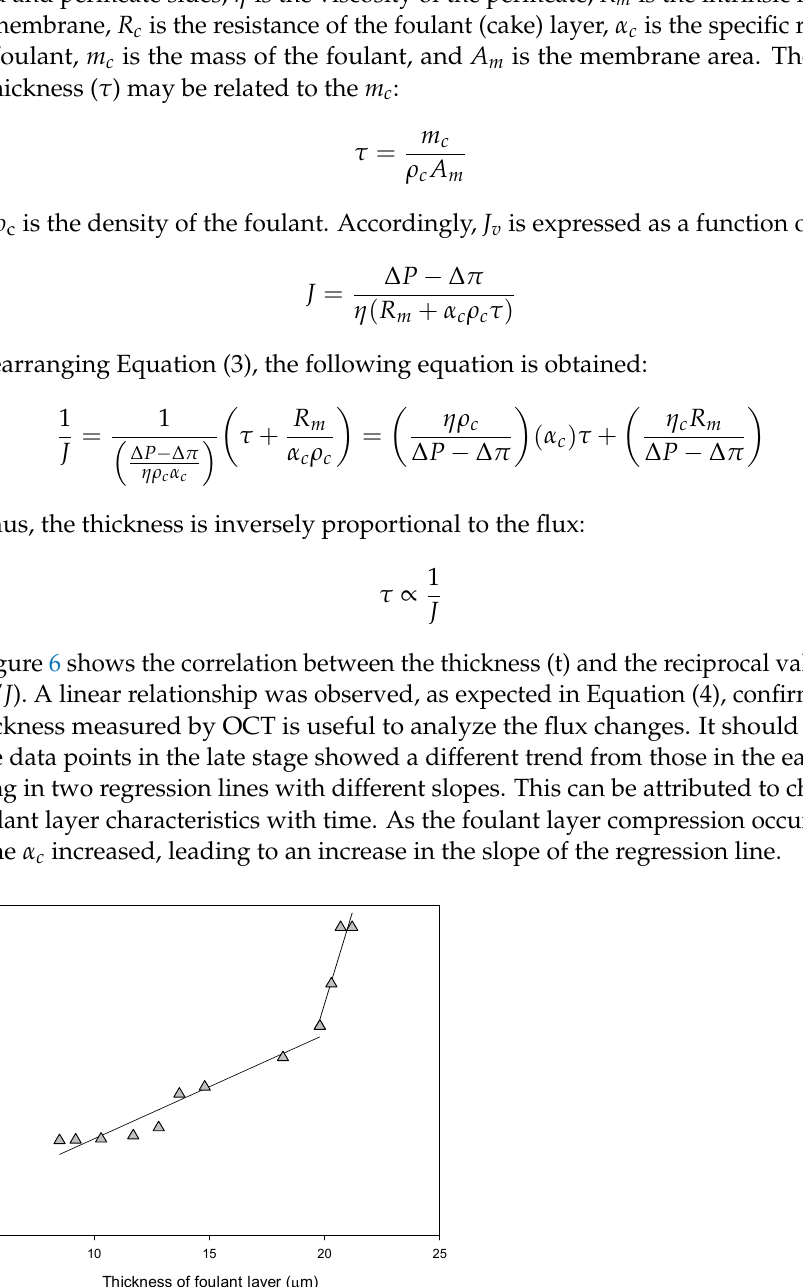
( b ) Figure 7. Time ‐ dependent pro fi les for fl ux and foulant layer thickness for 40 h of intermi tt ent operation. The red dashed line represents the time for stopping and restarting. black color is Case 2 operation, gray color is continuous operation, and white color is Case 3 operation. ( a ) RO operation with membrane storage in the feed water (Case 2). ( b ) RO operation with the membrane storage in DI water (Case 3). The previous results indicate that intermi tt ent operation causes fl ux recovery. To clarify the speci fi c mechanism, the changes in fouling layer thickness before and after